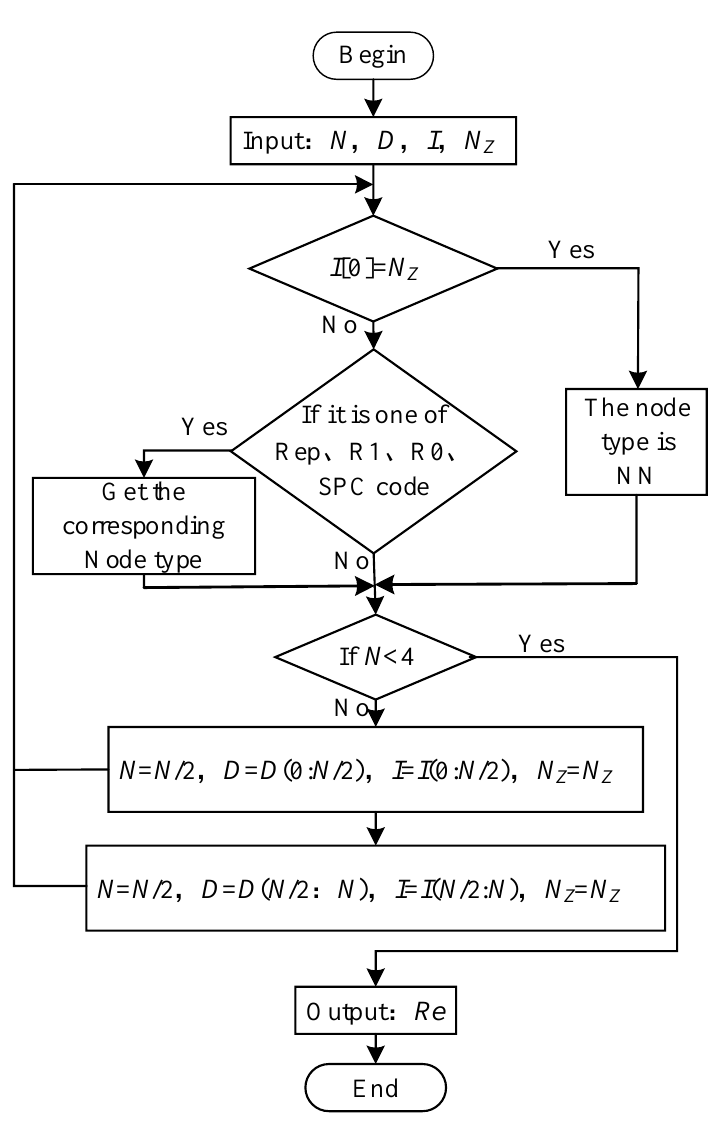
Figure 9. LSNNN identification flowchart.